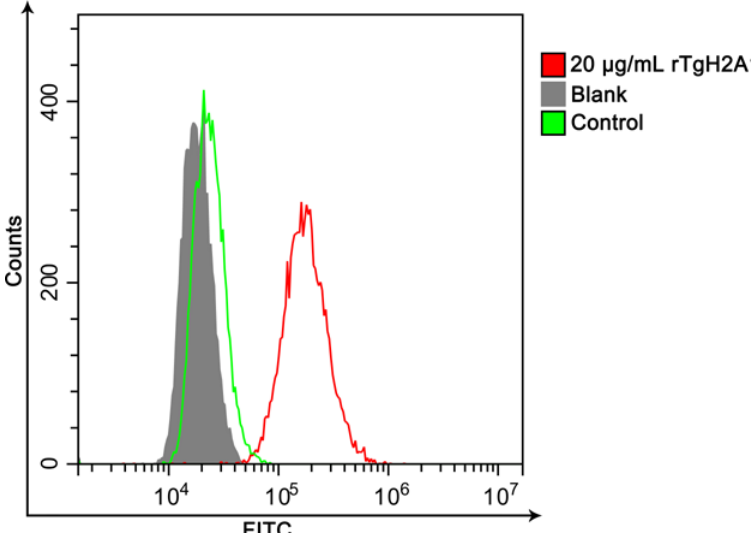
Figure 2. Representative FACS histograms showed a shift in fluorescence intensity of murine Ana-1 cells combined with rTgH2A1 labeled with FITC. In the blank group and control group, the Ana-1 cells were treated with PBS and purified his-tagged protein, respectively, while the experimental group was treated with purified recombinant TgH2A1 (20 μg/mL). After incubation, the mouse antirat IgG labeled with FITC was added.